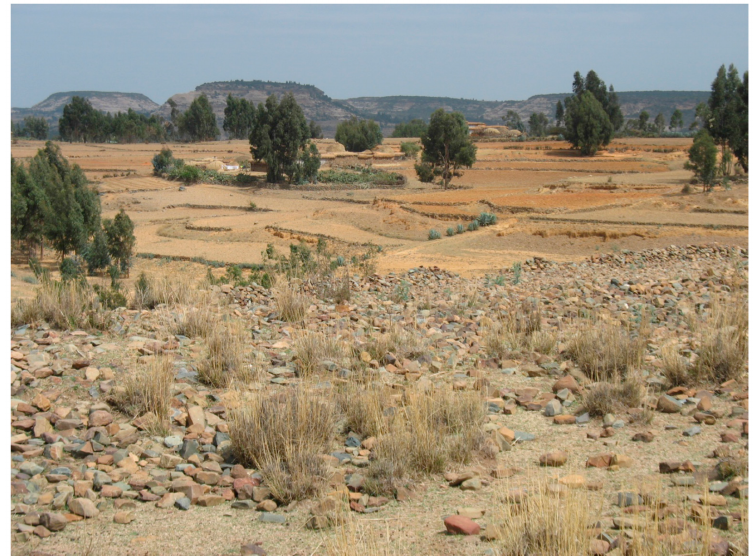
Figure 2. Landscape picture of part of the study area in Atsbi. In the picture two households with flat, straw covered roofs are visible, surrounded by stone bunds that also delineate the fields (Photo: Å.